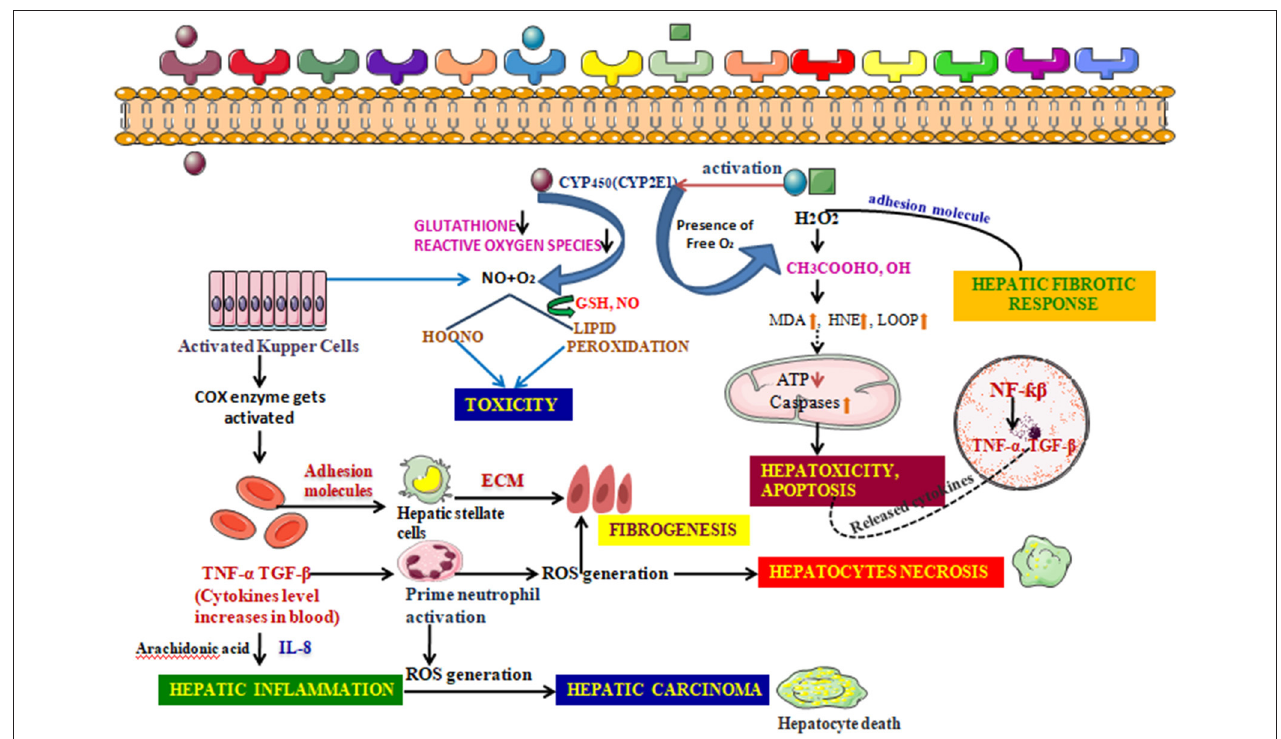
FIGURE 8 | Detailed Mechanism of generation of hepatotoxicity. When the elicitors like alcohol, CCl 4 , enter the cell membrane they instigate various metabolic reactions activating the CYP systems viz; activating the endogenous glutathione enzyme, hydrogen peroxide. Formation of the reactive oxygen species are responsible for the lipid peroxidation reaction. A conjugation reaction takes place alongside this resulting in the deterioration in the ATP levels and elevation in the caspases levels. This clinical manifestation leads to the building up of hepatotoxicity and induces apoptosis. The nucleus also takes part in such build up by upregulating various transcription factors associated with inflammation. The adhesion molecules present in the cell membrane further create a hepatic fibrotic response by coupling with various reactive oxygen species. The activated Kupffer cells, on the other hand, further activate the prostaglandin by COX-2 and thus increases the cytokines level in the blood. These reactions are catalyzed by arachidonic acid. Such atrocities give rise to associated diseases with inflammation and further fibrogenesis. Hepatic necrosis is another condition imparted by the activated neutrophil which, though inactive during a normal state, increase in number when the cytokine level increases in the blood. The fatal condition, hepatic cirrhosis, is also encountered from hepatotoxicity, which is the additive effect of the prolonged inflammation and interaction with the ROS